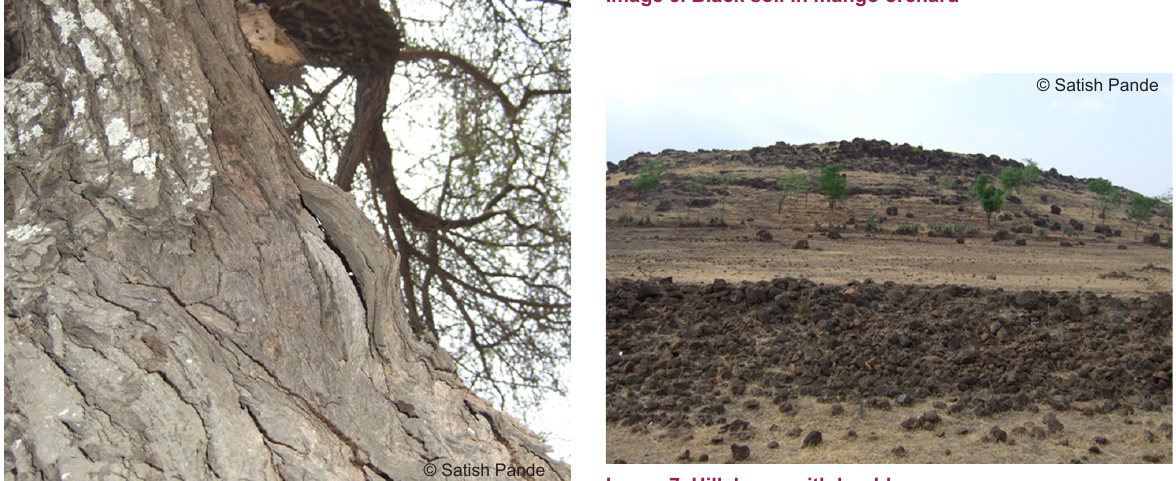
Image 7. Hillslopes with boulders